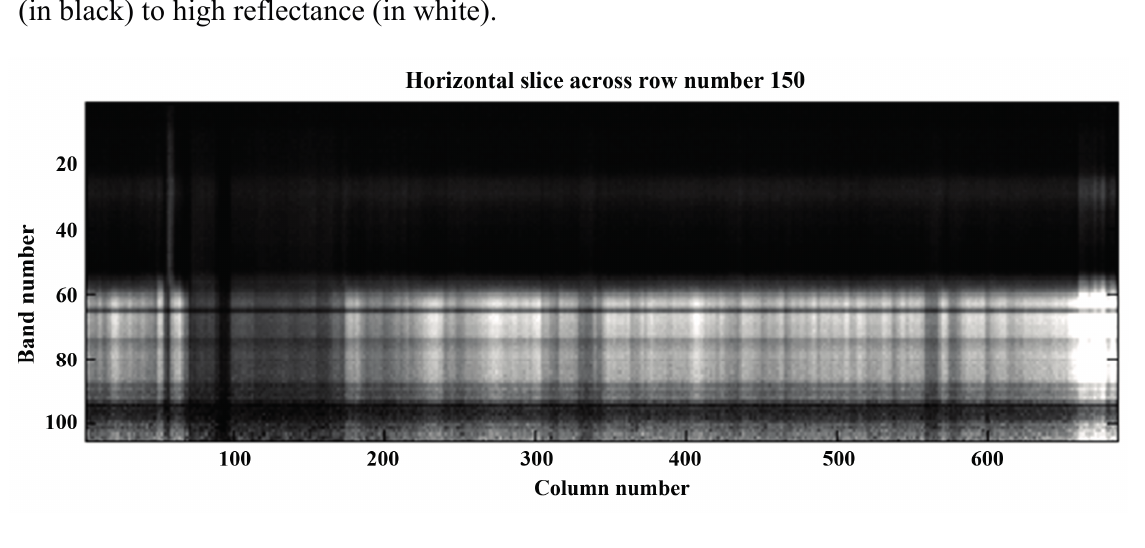
Figure 12. Horizontal slice of the image cube at row 150; a known vegetation mark is located between pixel 300 and 350. The shades of grey correspond to low reflectance (in black) to high reflectance (in